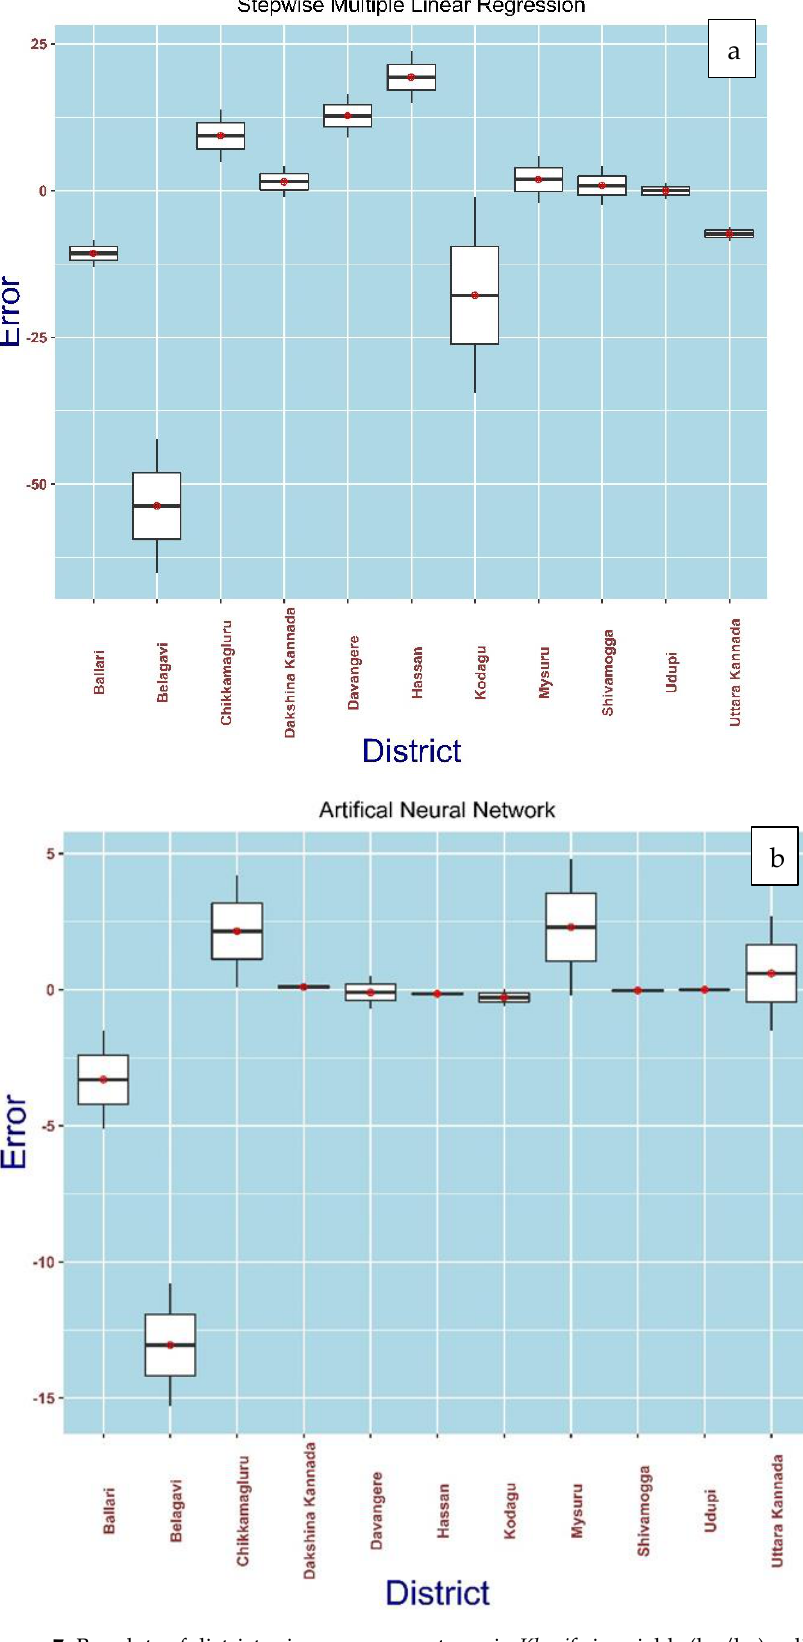
Figure 7. Boxplots of district-wise error percentages in Kharif rice yields (kg/ha) validated (2018 and 2019) using a stepwise multiple linear regression ( a ) and an artificial neural network ( b ). Table 8. Statistical evaluation of validated kharif rice yield using an artificial neural network (ANN).